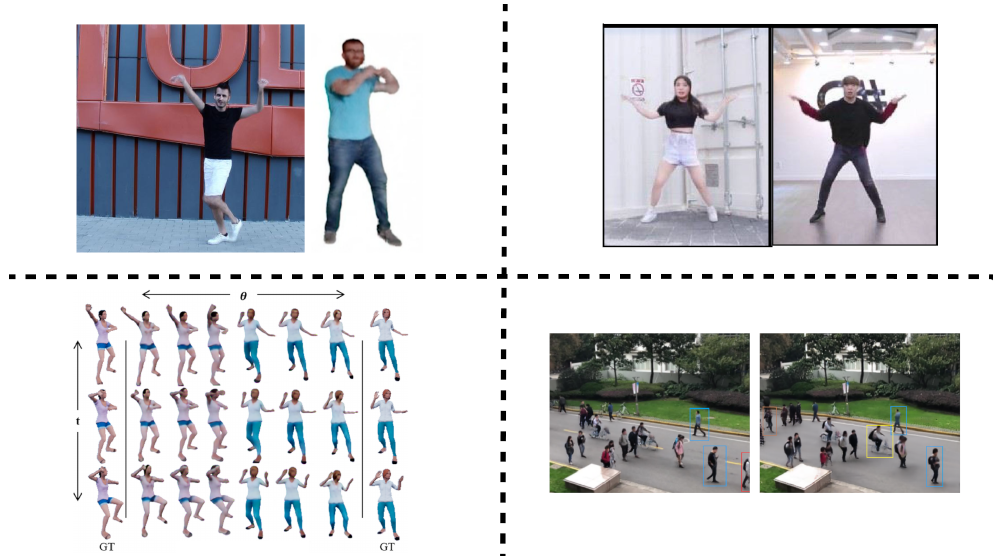
Figure 3. Examples of synthetic images generated by GAN models. Please refer to the original papers for more information. ( Upper left ) Aberman et al. [33]. ( Upper right ) Wei et al. [51]. ( Bottom left ) Kwon et al. [40]. ( Bottom right ) Chai et al.